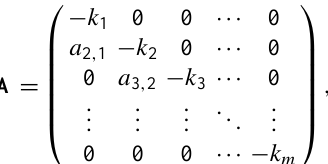
Fig. 1. Basic model structures implemented in S OIL R. Squares rep- resent the compartments, and arrows represent inputs and outputs to and from the compartments. These model structures are special cases of the matrix A